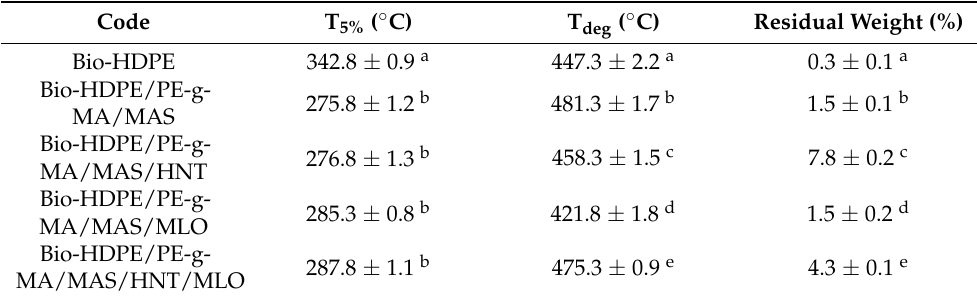
Figure 6. ( a ) Thermogravimetric analysis (TGA) curves and ( b ) first derivative (DTG) of Bio- HDPE/PE-g-MA/MAS blends with different compatibilizers. Table 4. Main thermal degradation parameters of the Bio-HDPE/MAS blends with different com- patibilizers in terms of the onset degradation temperature at a mass loss of 5 wt.% ( T 5% ), maximum degradation rate (peak) temperature ( T deg ), and residual mass at 700 ◦